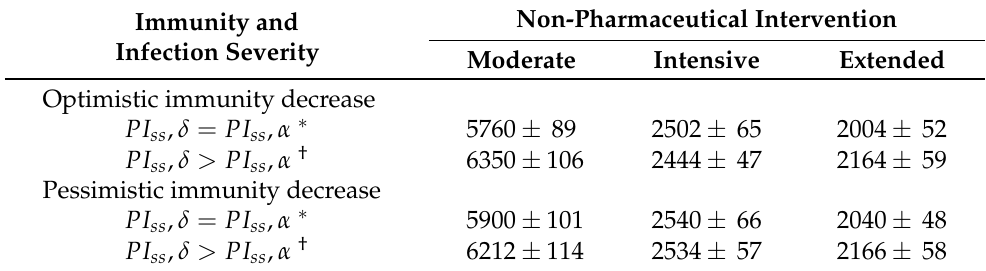
Table 3. Number of deaths ± SEM over 400 days in hypothetical combinations of non-pharmaceutical intervention levels, immunity decrease, and infection